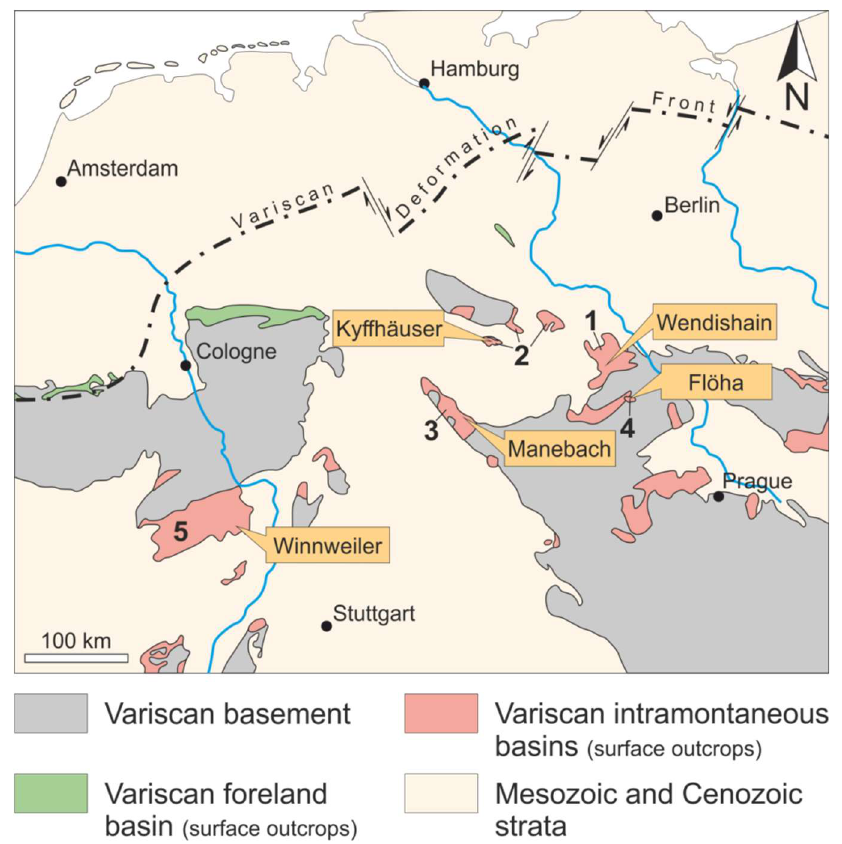
Figure 3. Generalized geological map of Central Europe showing the position of the selected localities. Modified after [48]. 1—NW Saxon Volcanic Complex; 2—Saale Basin; 3—Thuringian Forest Basin; 4—Flöha Basin; and 5—Saar-Nahe Basin.